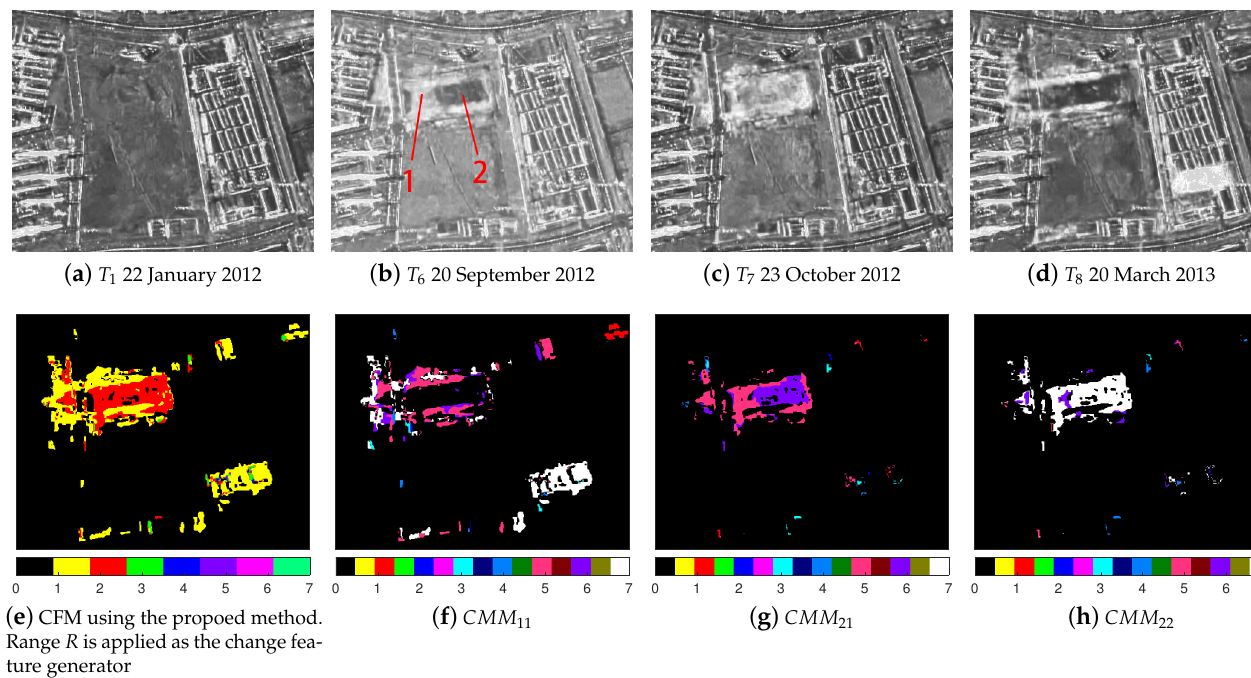
Figure 6. Four images of original data 1 (after denoising) are illustrated in the first line. The second line displays the change frequency map (CFM) and change moment maps (CMMs) of data 1. To conserve space, we only illustrate CMMs of objects whose CF ≤ 2 because very few objects change more than three